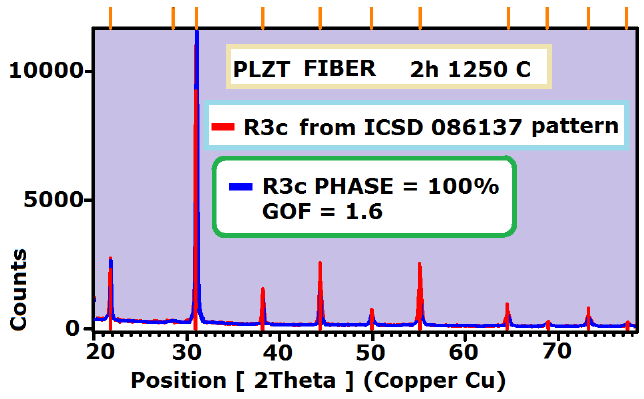
Figure 3. XRD diffraction pattern with the Rietveld approximation of PLZT